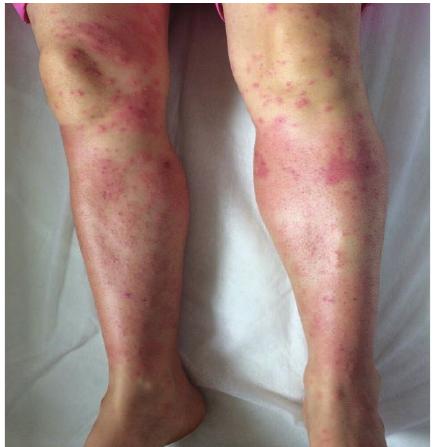
Figure3:Generalizedpapulovesicularandbullousrash,thefirstday of admission.